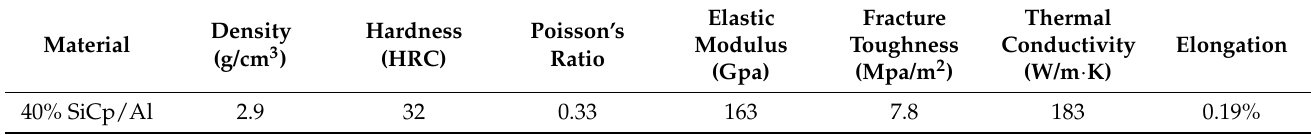
Figure 3. The 2UG-E-DM experimental device. Table 1. Physical properties of the composite